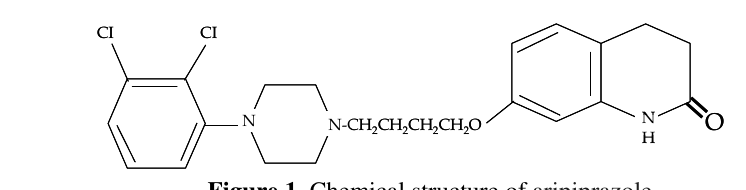
Figure 1. Chemical structure of